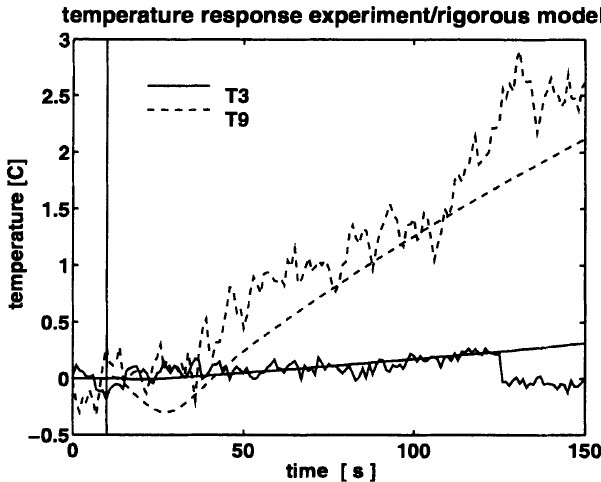
Figure 4. Experiment 2. Initial response of temperatures on trays 3 and 9 to a step change in heat input at t ó